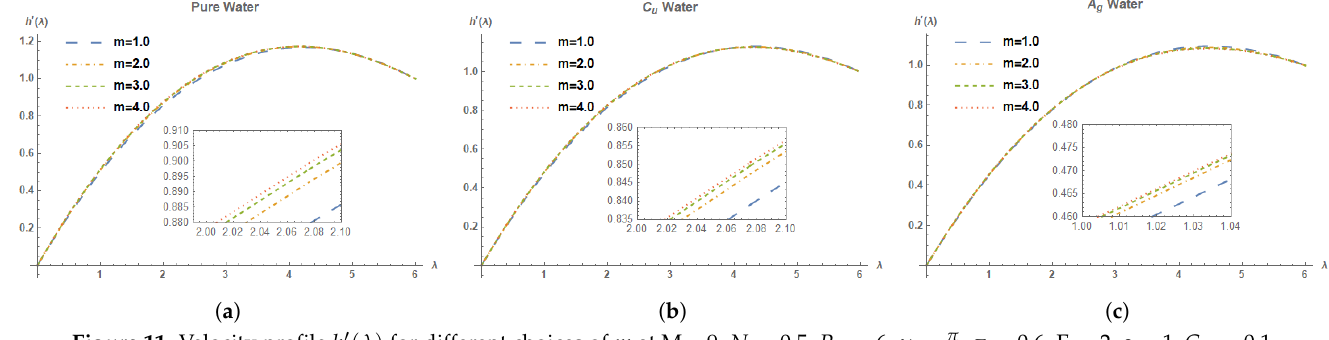
, τ = 0.6, Γ = 2, ε = 1, C T = 0.1, 6